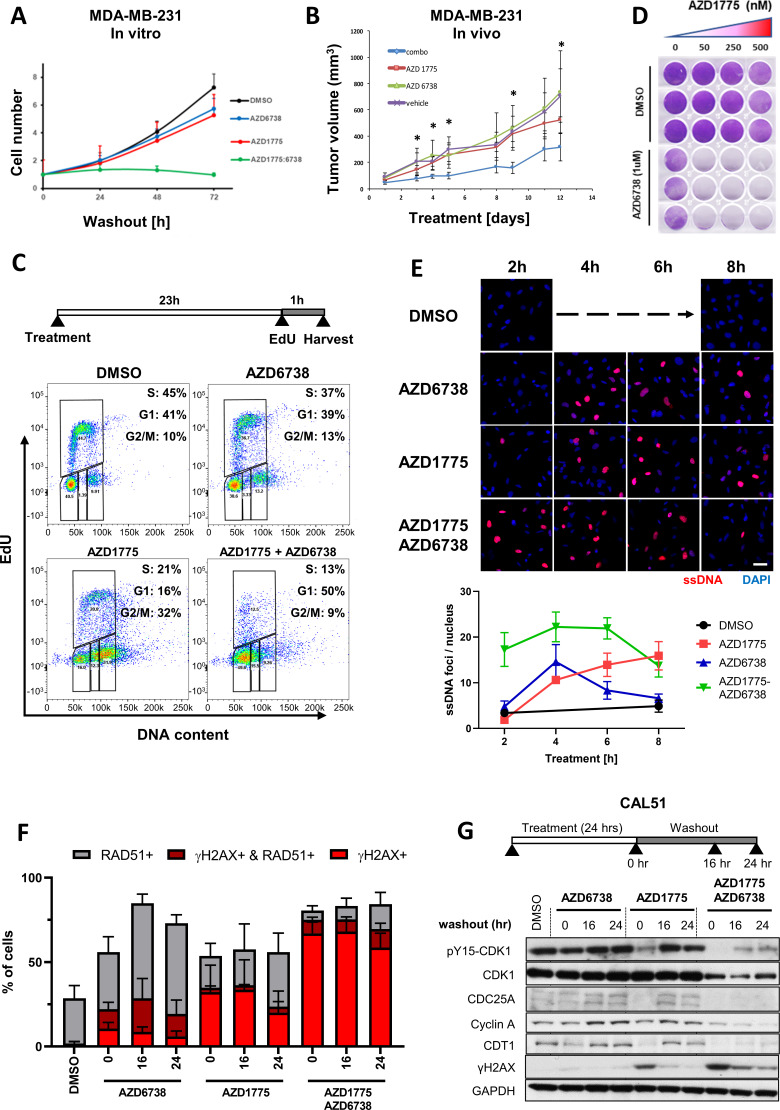
ATR inhibition by AZD6738 exacerbates AZD1775-induced RS and abrogates recovery of replication.(A) Quantification of cell proliferation post-drug treatment as indicated in MDA-MB-231 cells. Error bars indicate standard deviation calculated from three independent experiments. Cell proliferation was determined by trypan blue cell counting in triplicates for each condition. (B) Effect of the combination treatment with AZD1775 and AZD6738 on tumour growth in vivo. Mice (NOD/SCID female mice, 6–8 weeks old) were injected orthotopically with 106 MDA-MB-231 cells. As tumours reached 67.92mm3 +/- 10.66 mm3 (mean +/- SEM) mice started receiving one of the following treatments by oral gavage: vehicle (n = 4), AZD6738 25 mg/kg (n = 4), AZD1775 25 mg/kg (n = 4) or AZD6738 25 mg/kg + AZD1775 25 mg/kg (‘combo’) (n = 6) for 12 days. Tumours were measured periodically, and tumour volume calculated with the formula: V = D X d2 X π/6, where V is volume, D is the largest diameter, d is the shortest diameter. *p<0.05 as assessed by Student’s t-test with respect to combination treatment vs. vehicle. The statistical analysis is based on tumour growth index that is the relative increase in tumour volume at a particular time point compared with the tumour volume at the start of treatment for each tumour. (C) DNA replication in MDA-MB-231 cells treated as indicated was assessed by flow cytometry. Cells were pulse-labelled with EdU for one hour at the end of the treatment before fixation and staining. Cells were gated for EdU and DNA content (propidium iodide) to determine cell cycle phase. Y- and X-axes represent EdU incorporation and DNA content, respectively. (D) MDA-MB-231 cells were treated with increasing concentrations of AZD1775 alone (50, 250 and 500 nM) or in combination with AZD6738 (1 µM) for three days, and recovery of proliferation was assessed four days post-treatment by crystal violet staining. (E) Representative, high-magnification images related to Figure 3—figure supplement 2A visualizing ssDNA DNA by native BrdU staining (red) in response to AZD1775, AZD6738 or the combination treatment in MDA-MB-231 cells as indicated. Quantification of ssDNA in response to the different treatment times is depicted with error bars indicating SEM calculated from five replicates. Scale bar = 30 μM. (F) Quantification of data from HCI analysis of MDA-MB-231 cells treated with AZD1775 (500 nM), AZD6738 (1 µM) or their combination as indicated (Figure 3—figure supplement 2C). The staining signals of RAD51 and γH2AX were measured at single cell resolution (DAPI-stained area) and the fraction of RAD51/γH2AX-positive cells were quantified and shown as histograms with error bars, standard deviation derived from three independent replicates. (G) Expression level and phosphorylation of cycle regulatory proteins during the course of recovery following treatment with AZD1775 (500 nM), AZD6738 (1 μM), or their combination in recovering Cal51 cells. CDC25A, cyclin A, CDT1, phosphorylation of CDK1-Y15 and γH2AX was analysed by western blotting as indicated. GAPDH expression level served as loading control.
Figure 3—source data 1.ATR inhibition by AZD6738 exacerbates AZD1775-induced RS and abrogates recovery of replication.(E) Quantification of ssDNA foci numbers per nucleus in response to different treatments and durations as indicated. (F) Quantification of γH2AC, RAD51 and 53BP1 (the latter not shown in histograms) positive MDA-MB-231 cells treated with AZD1775 (500 nM), AZD6738 (1 µM) or their combination. (Supplement 1C) Quantification of percentage of cell population in active S-phase (EdU+) from two independent experiments in MDA-MB-231 and BT20 cells. (Supplement 1D) Proportion of senescence associated-β-Galactosidase-positive cells after 72 hr of AZD1775-AZD6738 combination or DMSO control treatment (500 nM AZD1775 and 1 μM AZD6738) and 5 days drug wash-out.